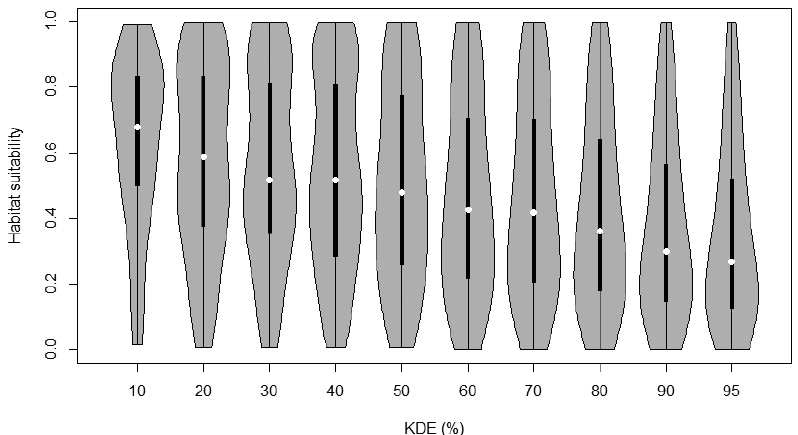
Figure 4. Violin plots of the habitat suitability within the 10 areas delineated by kernel density estima- tions (KDE) for Cerambyx cerdo L., 1758 in SW Poland. White dots indicate medians, box edges repre- sent the inter-quartile range and the grey region and curve show the probability density